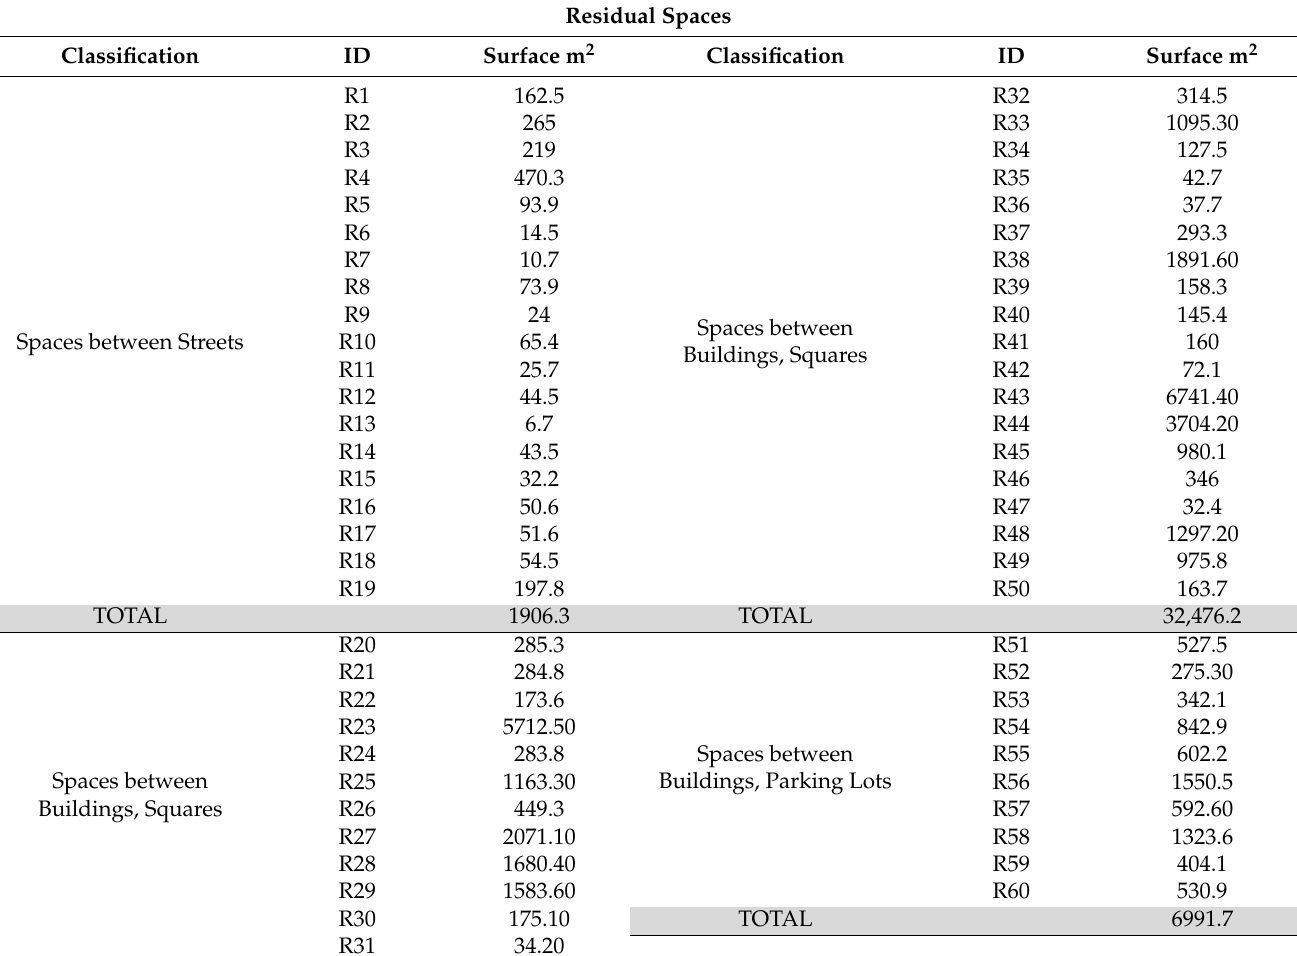
Figure 13. Map of vertical residual spaces of La Milagrosa: walls and party walls. Table 2. Residual surface spaces in La